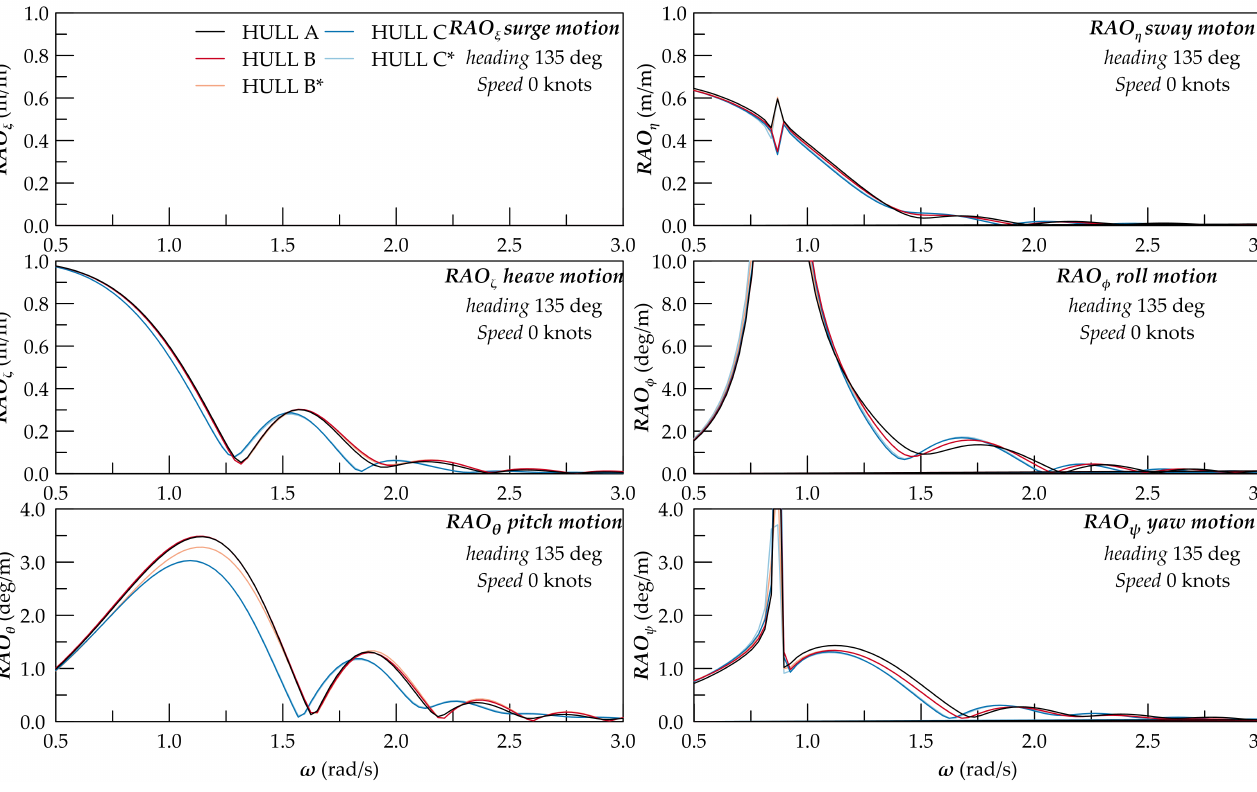
Figure 10. Six DOF RAOs at 0 knots on the reference hulls for the AWI heading of 135 degrees.